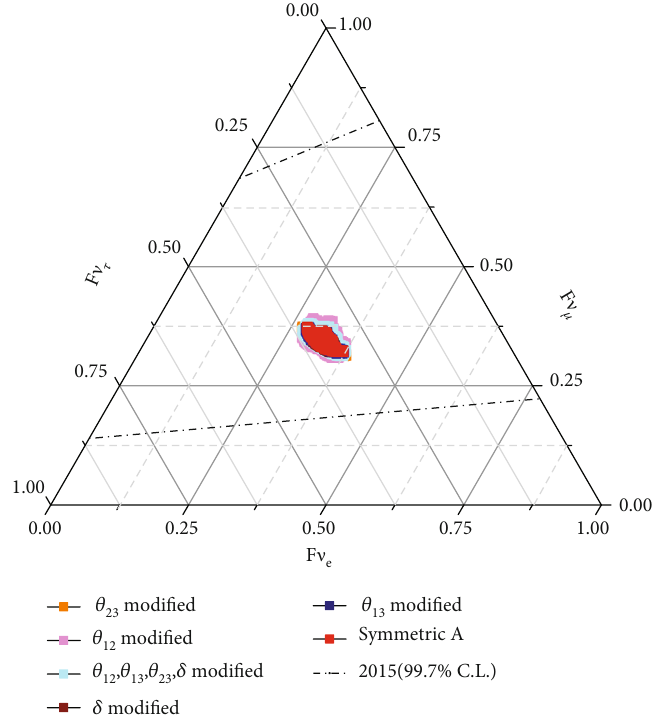
Figure 5: The fl avor ratio at Earth with the pion-decay source ð 1/3, 2/3, 0 Þ . The conventions of the mixing parameters are the same as those in Figure